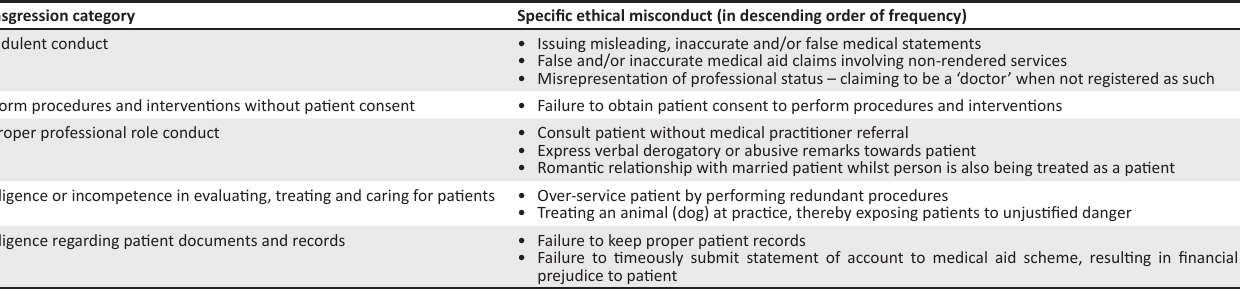
TABLE 5: Specific ethical misconduct by sanctioned physiotherapists within each transgression